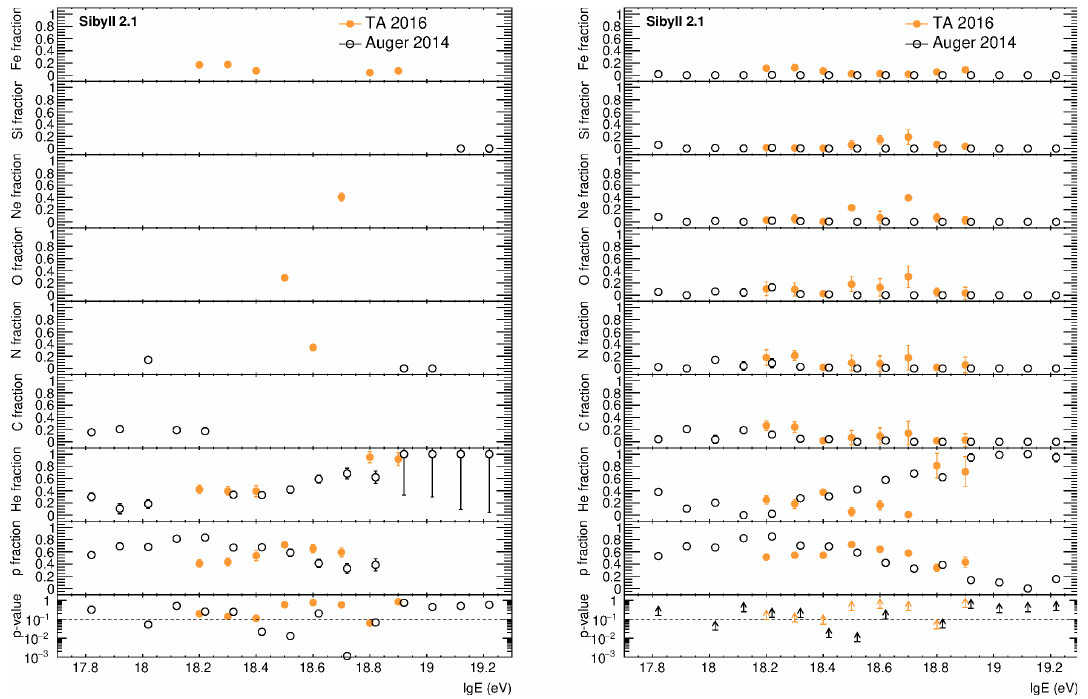
Figure 4. Fitted fractions of individual nuclei in each energy interval obtained with method #1 ( left ) and method #2 ( right ) employing the Sibyll 2.1 hadronic interaction model. Full orange circles stand for TA (2016) data while the black open circles represent the Auger (2014) data. The p-value parameters are displayed on the bottom panels as one single value per energy interval ( left ) and a range of p-values represented with arrows ( right ) (see